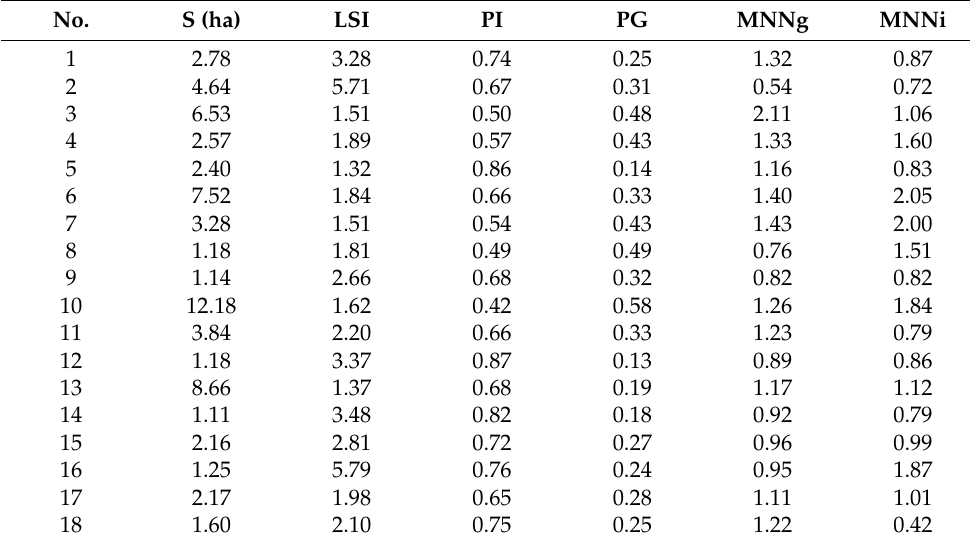
Table 5. Quantification results of WCI impact factors.